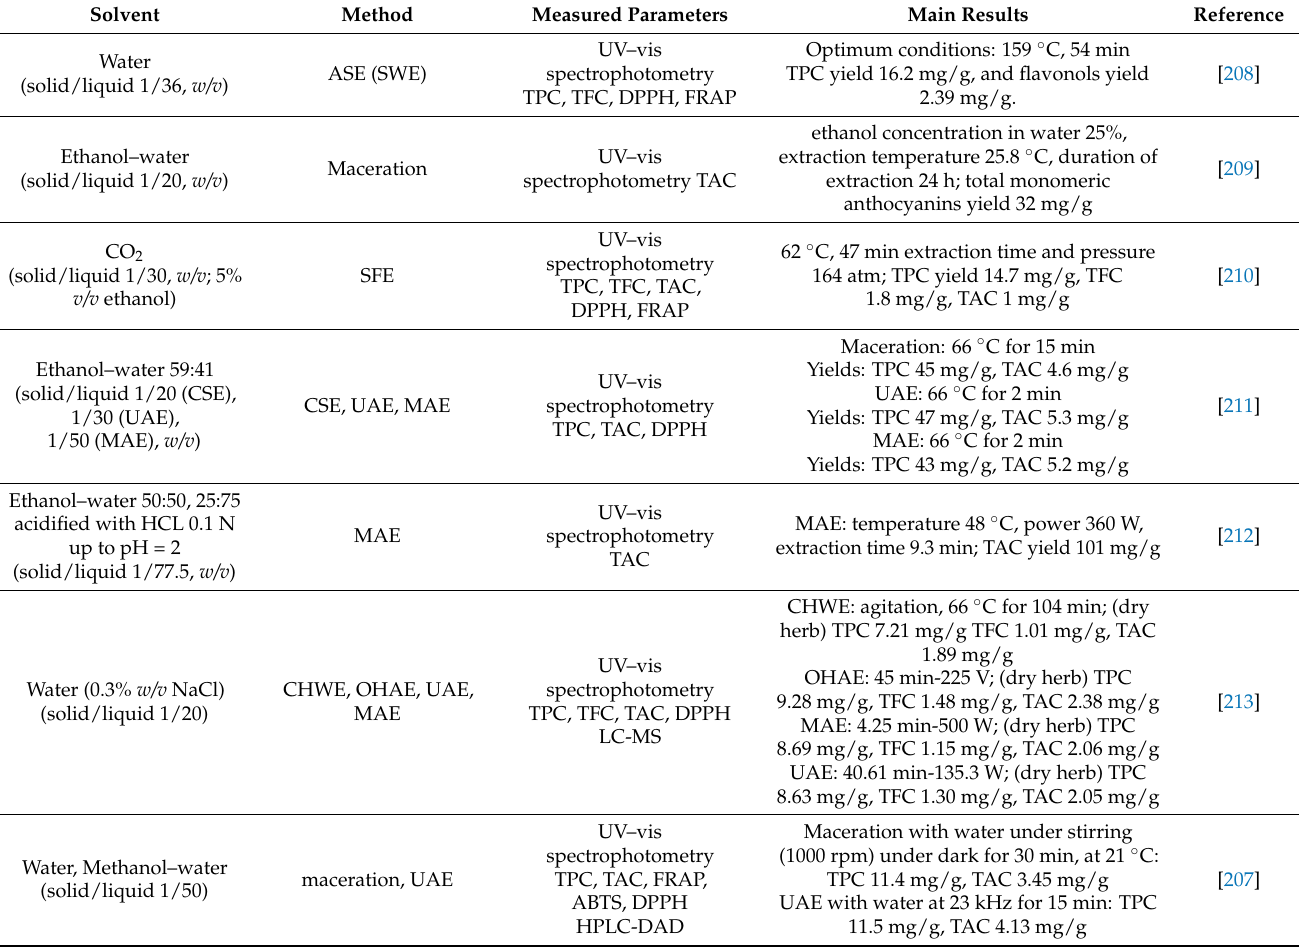
Table 8. The extraction parameters of Crocus sativus petals, as obtained from the review of literature. Solvent Method Measured